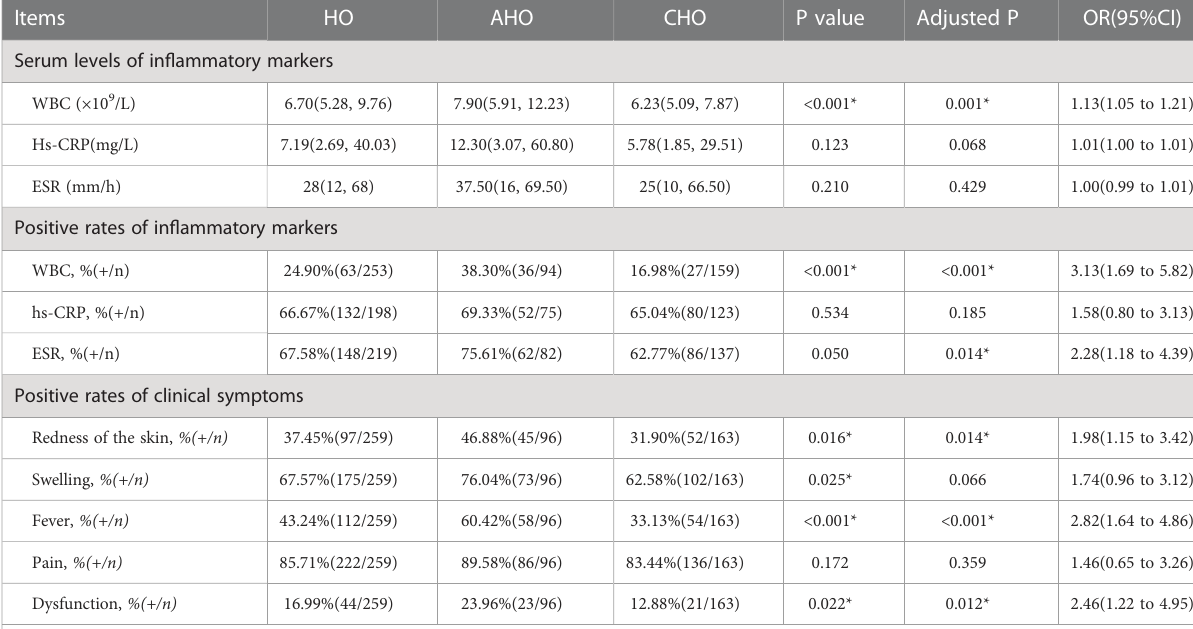
TABLE 2 In fl ammatory markers and clinical symptoms. Items